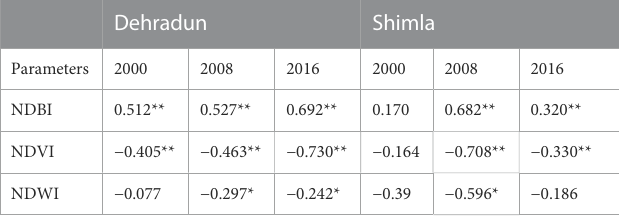
TABLE 3 Pearson ’ s correlation between LST and biophysical